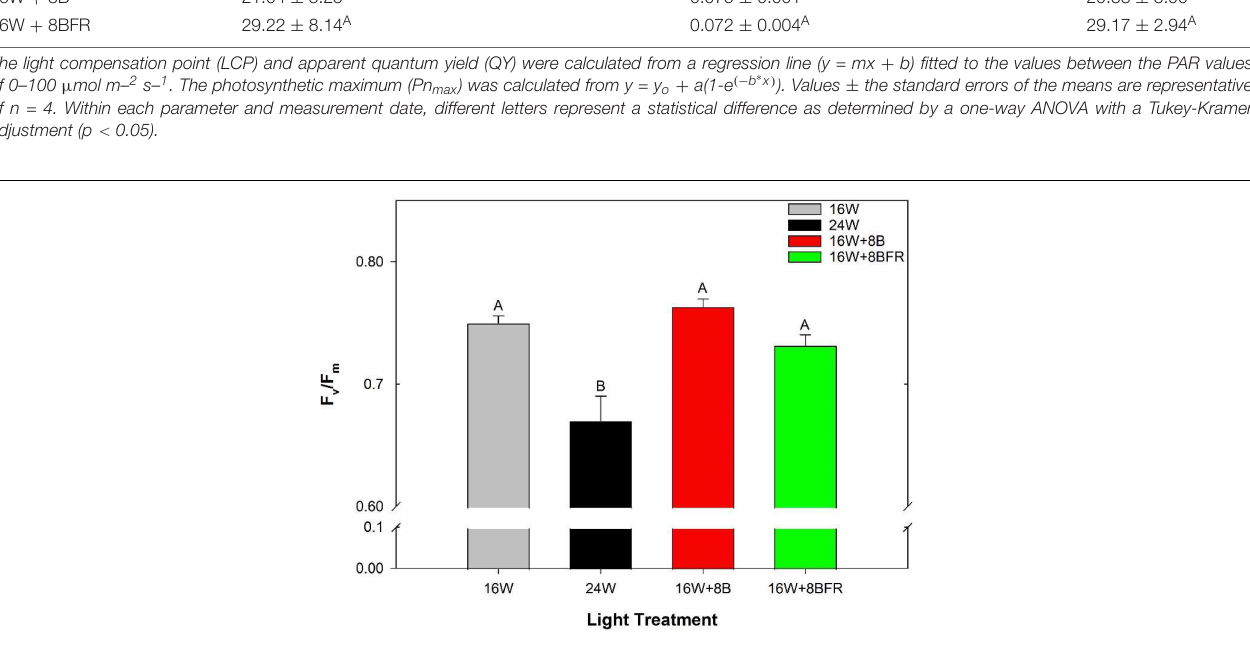
FIGURE 5 | Maximum efficiency of PSII (F v /F m ) of the fifth leaf from peppers grown under all light treatments at 110 DIT. Error bars represent the standard errors of the means of n = 8. Letter groups (A, B) represent a statistical difference as determined by a one-way ANOVA with a Tukey-Kramer adjustment ( p < 0.05).